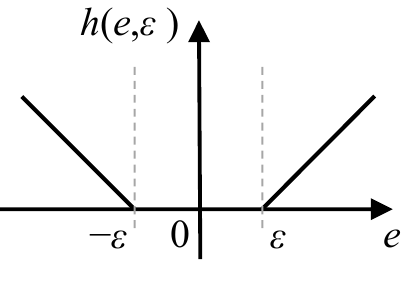
Figure 5. Hinge loss function.